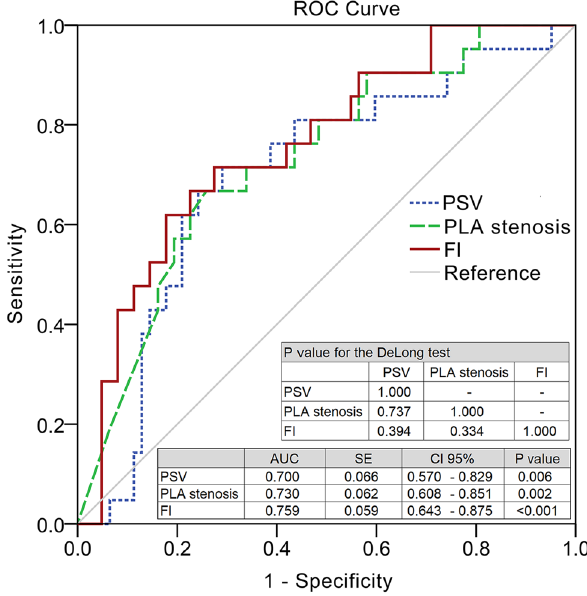
Figure 1. ROC Curve of EHS < 3. PSV, PLA stenosis, and FI exhibited acceptable AUCs in ROC analysis. AUC = 0.5 (no discrimination), 0.5–0.6 (poor discrimination), 0.6–0.7 (fair discrimination), 0.7–0.8 (acceptable discrimination), 0.8–0.9 (excellent discrimination), and 0.9–1.0 (outstanding discrimination). The DeLong test of AUC revealed no significant difference between the AUCs of PSV, PLA stenosis, and FI. EHS: erection hardness score, FI: flow index, PSV: peak systolic velocity, PLA: pelvic